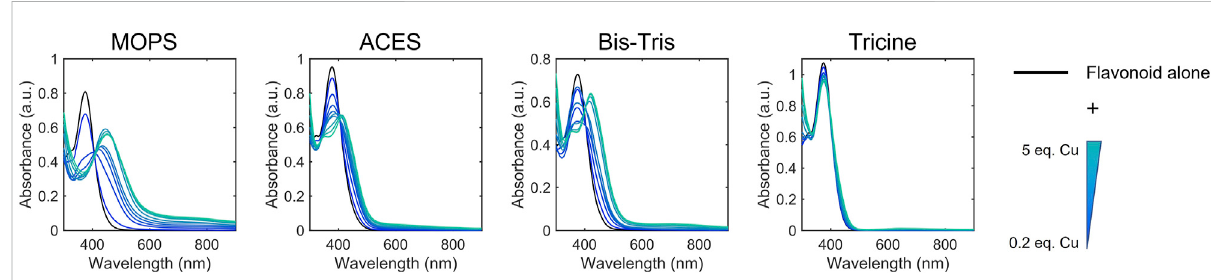
FIGURE 3 Representative electronic absorbance spectra of QT and CuSO 4 in various 50 mM buffers (pH 7.4) for determining binding af fi nity ranges. CuSO 4 was titrated into a 50 μ M solution of QT from 0.2 to 5 equivalences. Spectral changes correspond to binding between QT and Cu(II) which indicatesthatQThasastrongerbindingaf fi nitythanthecorrespondingbuffer.Conversely,thelackofspectralchangesuponCu(II)additionintricine